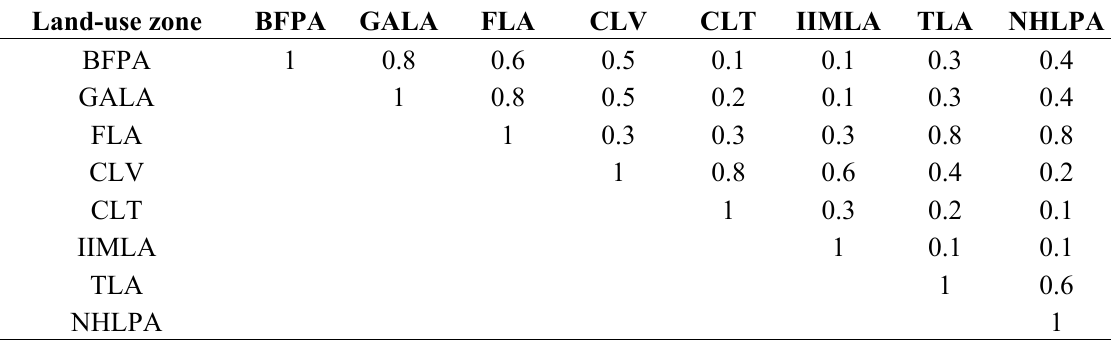
Table 3. The spatial harmony index between different land-use zones.